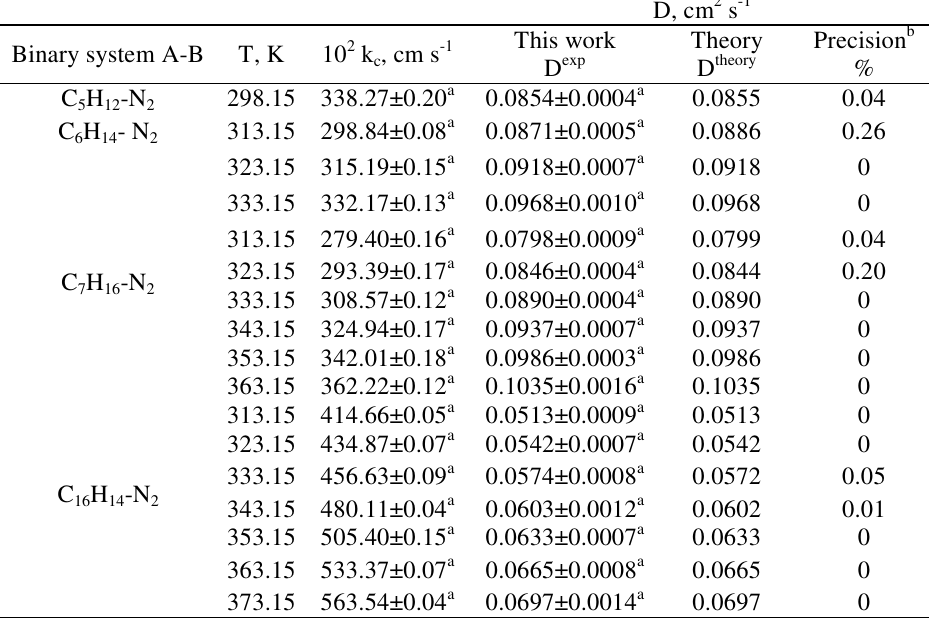
Table 1 Binary gaseous diffusion coefficients, D solute, B: carrier gas), measured by the reversed-flow gas chromatographic